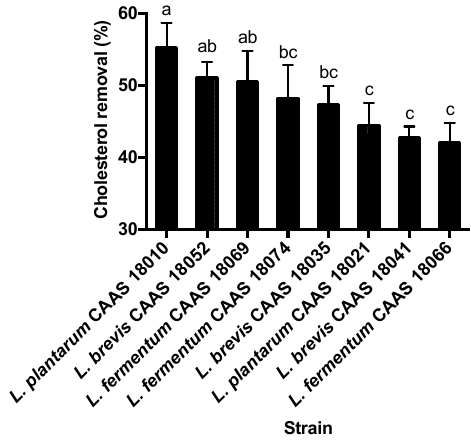
Figure 1. Comparison of lactic acid bacterial strains for cholesterol removal ability. Data are represented as the mean ± SD ( n = 3). Means not sharing a common letter differ significantly from each other ( p < 0.05).